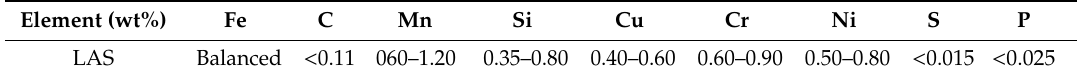
Table 2. The chemical composition (wt%) of the LAS.